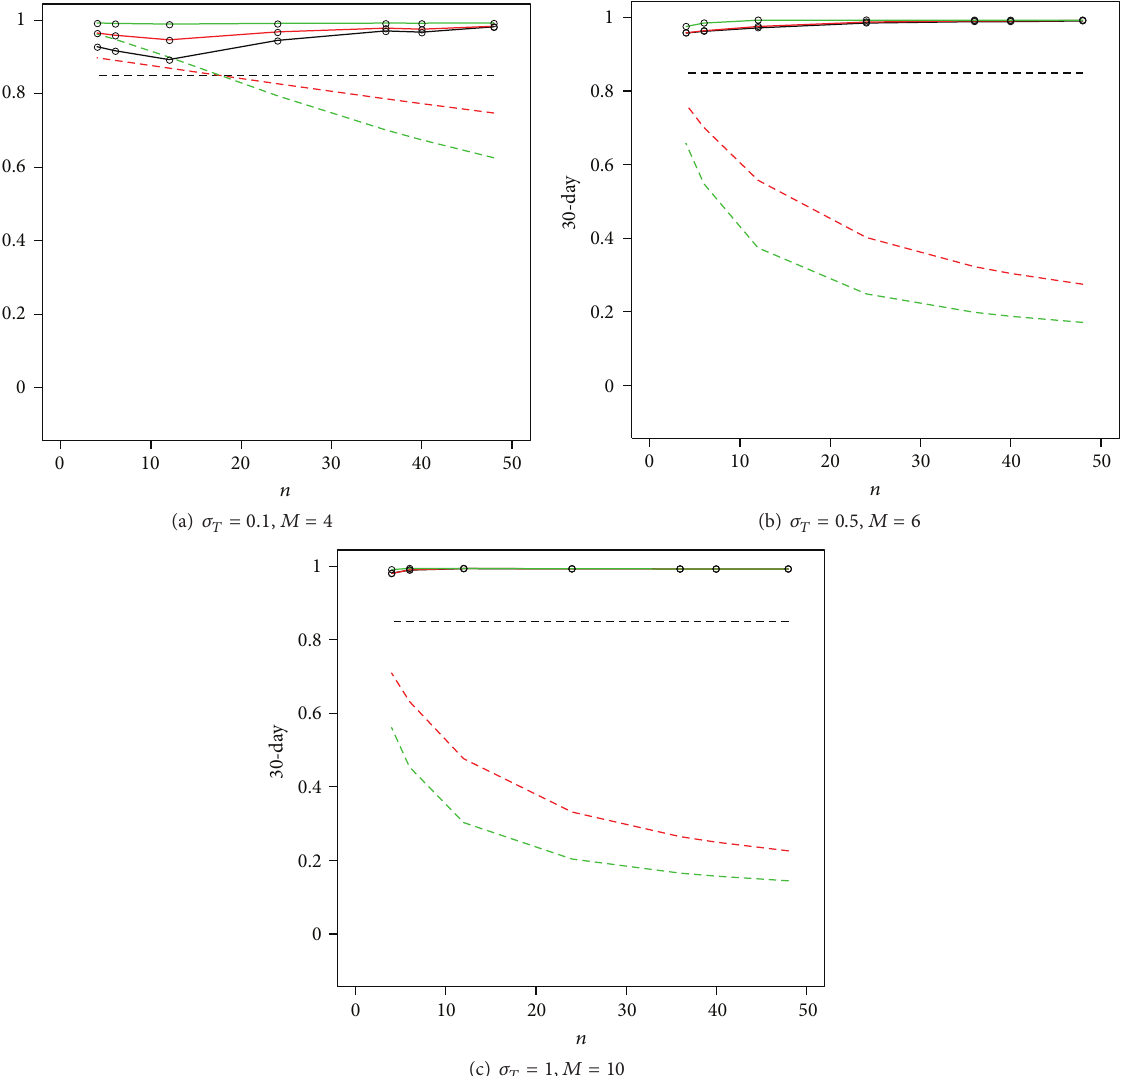
Figure 8: Timeliness AP for abrupt threat using SITMUF joint cusum for 𝑛 = 4,6, 12, 24, 36, 40, 48 . (Colors black, red, and green correspond to Σ 1 – Σ 3 . Dashed lines are for 1-year